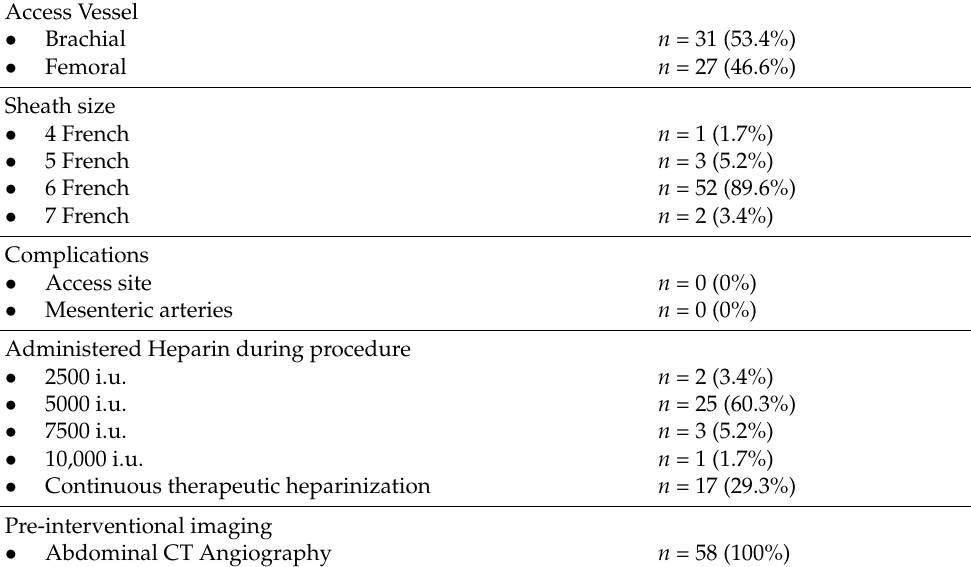
Table 2. Details of